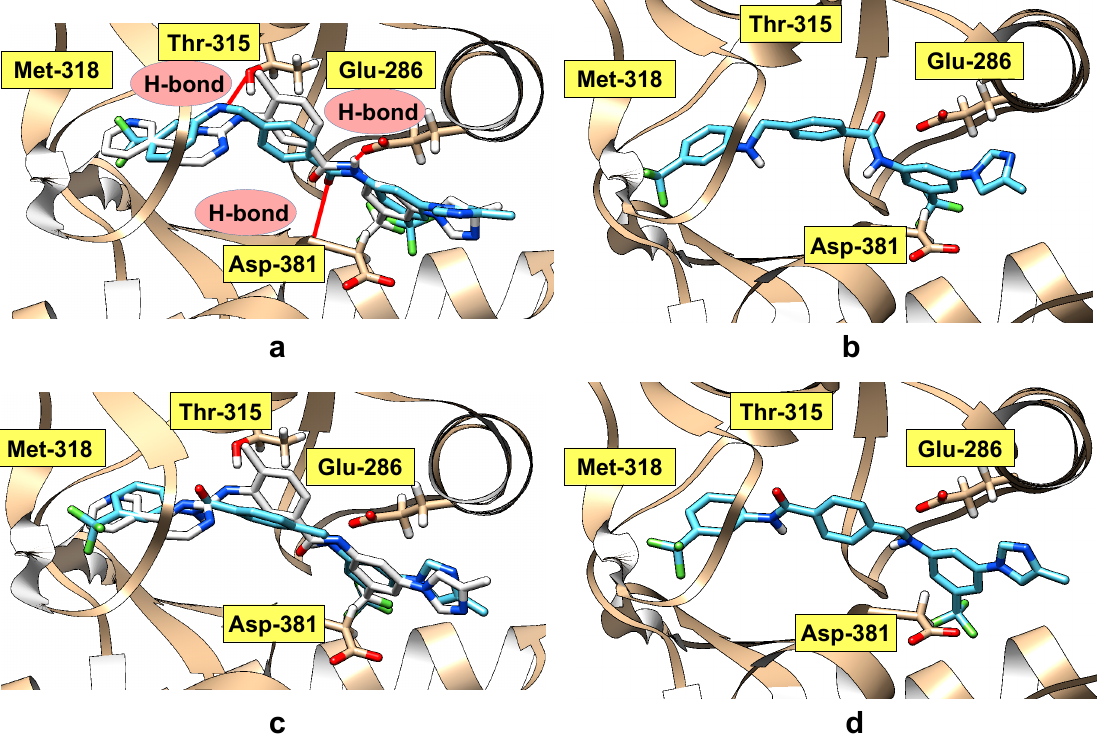
Figure 3. Binding models of inhibitor 11 and 13 to Abl-wt kinase. Hydrogen bonds are indicated by red lines to key amino acids. Experimental binding model of nilotinib is shown in white ( a, c ). ( a ) Binding model of 11 with Abl (PDB: 3CS9; H-bond—Thr-315, Glu-286, Asp-381). ( b ) Binding model of 11 with Abl (PDB: 2HYY; H-bond—non-detected). ( c ) Binding model of 13 with Abl (PDB: 3CS9; H-bond—non-detected). ( d ) Binding model of 13 with Abl (PDB: 2HYY; H-bond—non-detected).